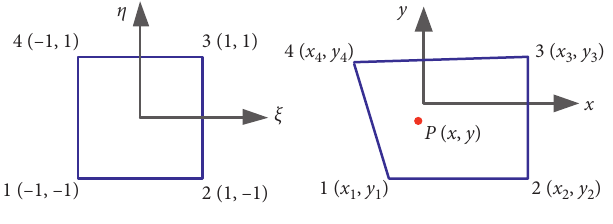
Figure 3: Isoparametric mapping.